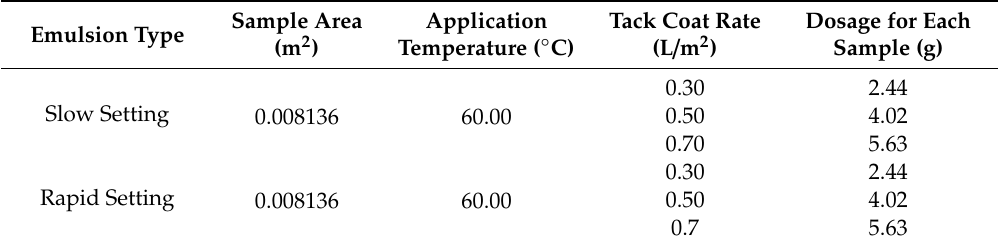
Table 2. Proportions of the